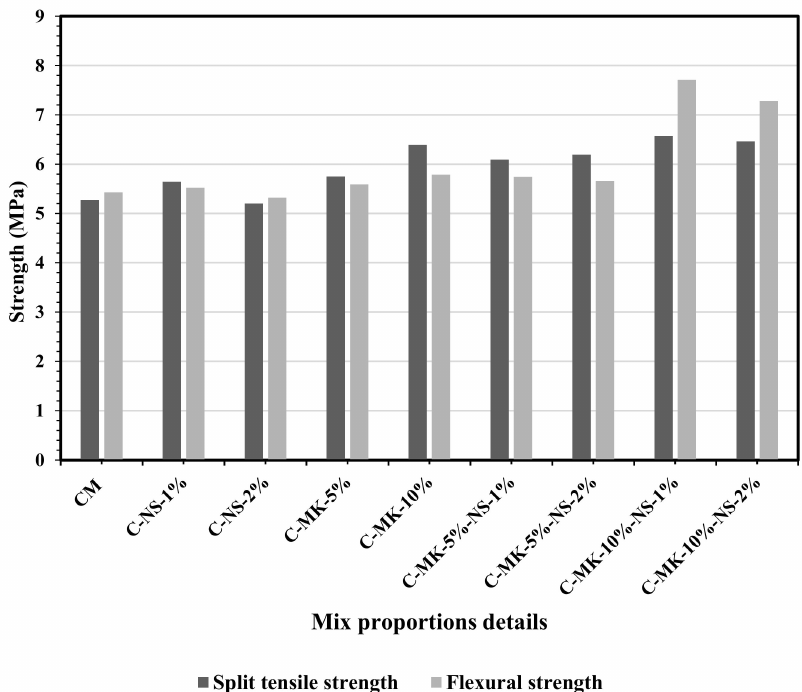
Figure 2. The e ff ects various combinations of MK + NS on the flexural and split tensile strength of concrete determined at the age of 28